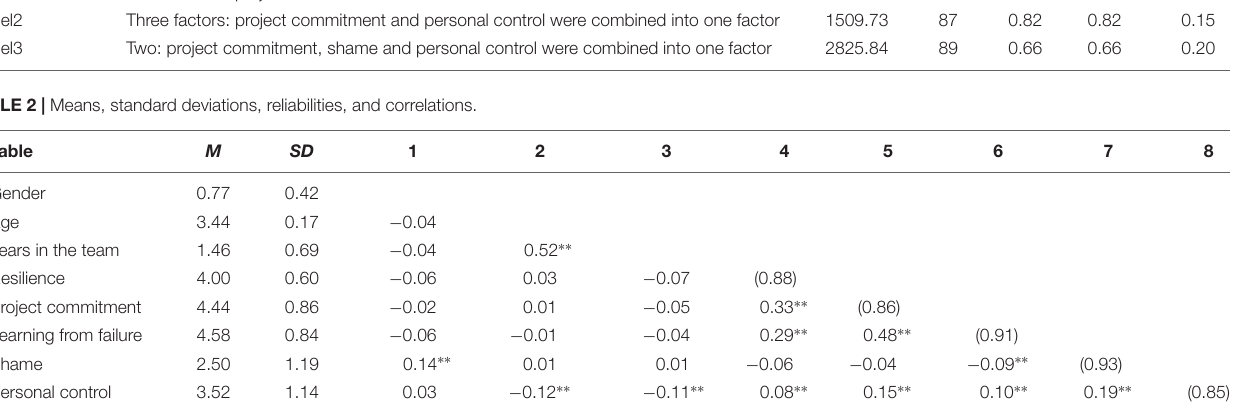
Table 4 , the coefficients of project commitment ( b =